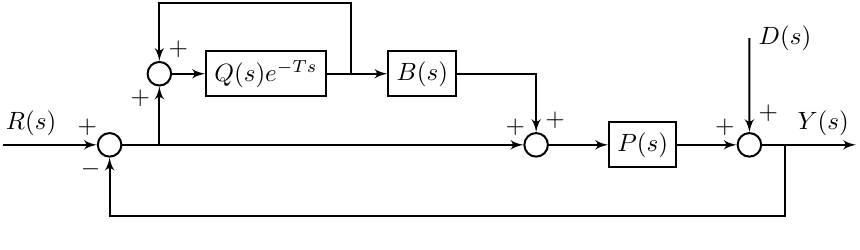
Figure 6. The structure of plug-in repetitive control (RC).